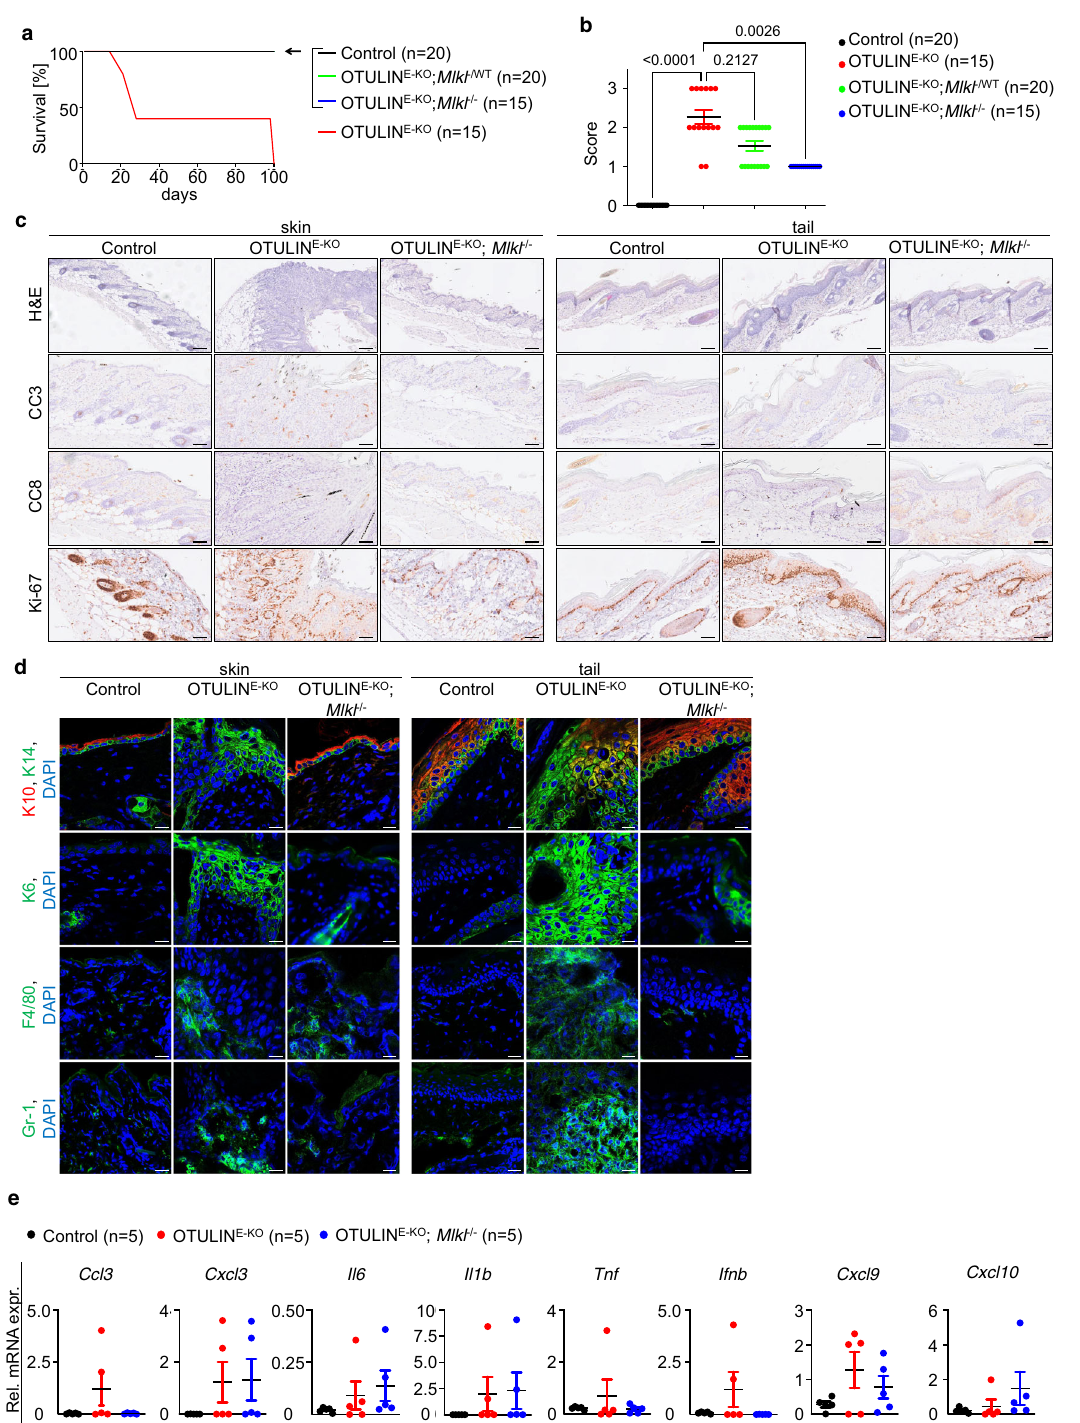
Fig. 6 MLKL-mediated necroptosis triggers skin in fl ammation in OTULIN E-KO mice. a Kaplan – Meier plot depicting survival of mice of the indicated genotypes. b Graph depicting macroscopic skin score of mice of the indicated genotypes. The dots in the graphs represent individual mice. Mean ± s.e.m. is shown for each group of mice in all graphs. Statistical signi fi cance was determined using Kruskal – Wallis test (one-sided). c Representative images of skin sections from 3-week-old mice of the indicated genotypes, stained with H&E ( n = 4) or immunostained with anti-CC3 ( n = 3), anti-CC8 ( n = 3) or anti-Ki- 67 ( n = 3) antibodies. Scale bars: H&E = 100 μ m; CC3, CC8, Ki-67 = 50 μ m. d Representative images from skin sections from 3-week-old mice of the indicated genotypes, immunostained with anti-K10, anti-K14 ( n = 4), anti-K6 ( n = 3), anti-F4/80 ( n = 3) and anti-Gr-1 ( n = 3) antibodies and counterstained with DAPI (DNA stain). Scale bars: K10, K14, K6 = 20 μ m; F4/80, Gr-1 = 30 μ m. e Graphs depicting relative mRNA expression of the indicated genes in RNA from whole-skin tissue of 3-week-old mice of the indicated genotypes, measured by qRT-PCR. The dots in the graphs represent individual mice. Mean ± s.e.m. is shown for each group of mice in all graphs. Statistical signi fi cance was determined using Kruskal – Wallis test (one-sided). Control mice include littermates that do not express K14-Cre . Source data for a , b , e are provided as a Source data fi